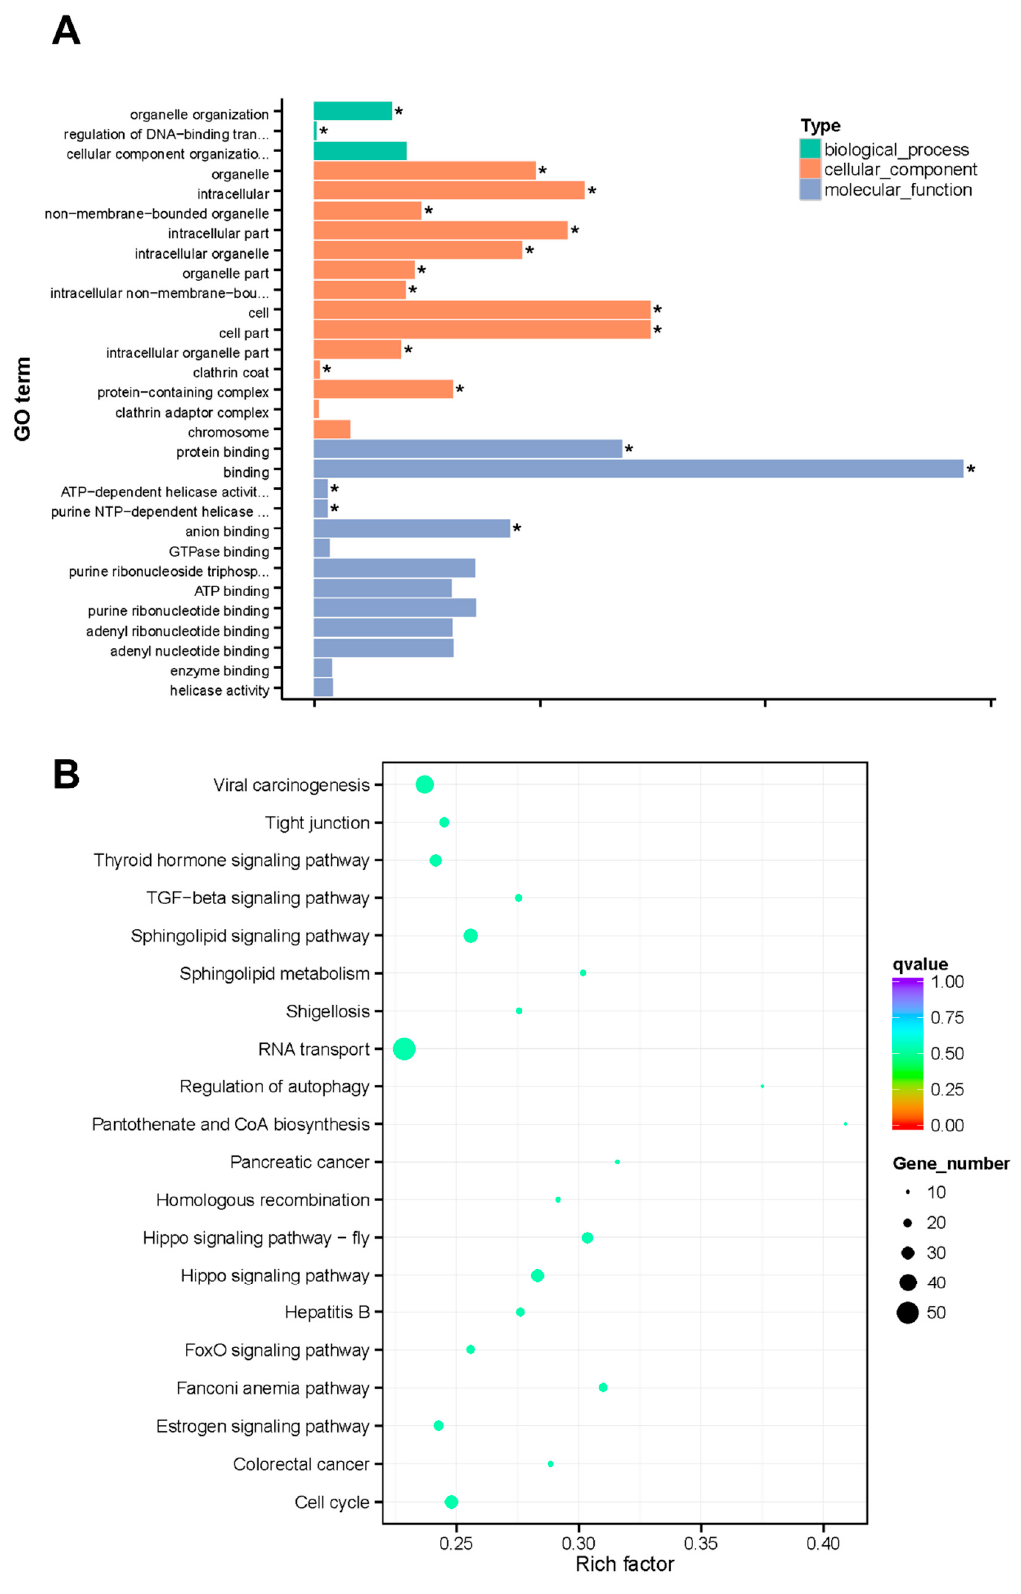
Figure 6. GO and KEGG enrichment analyses of cold vs. control CG DMR genes of the H . longicornis adults. ( A ). Most enriched GO terms. ( B ). KEGG pathway enrichment. * Significantly enriched (corrected p < 0.05).